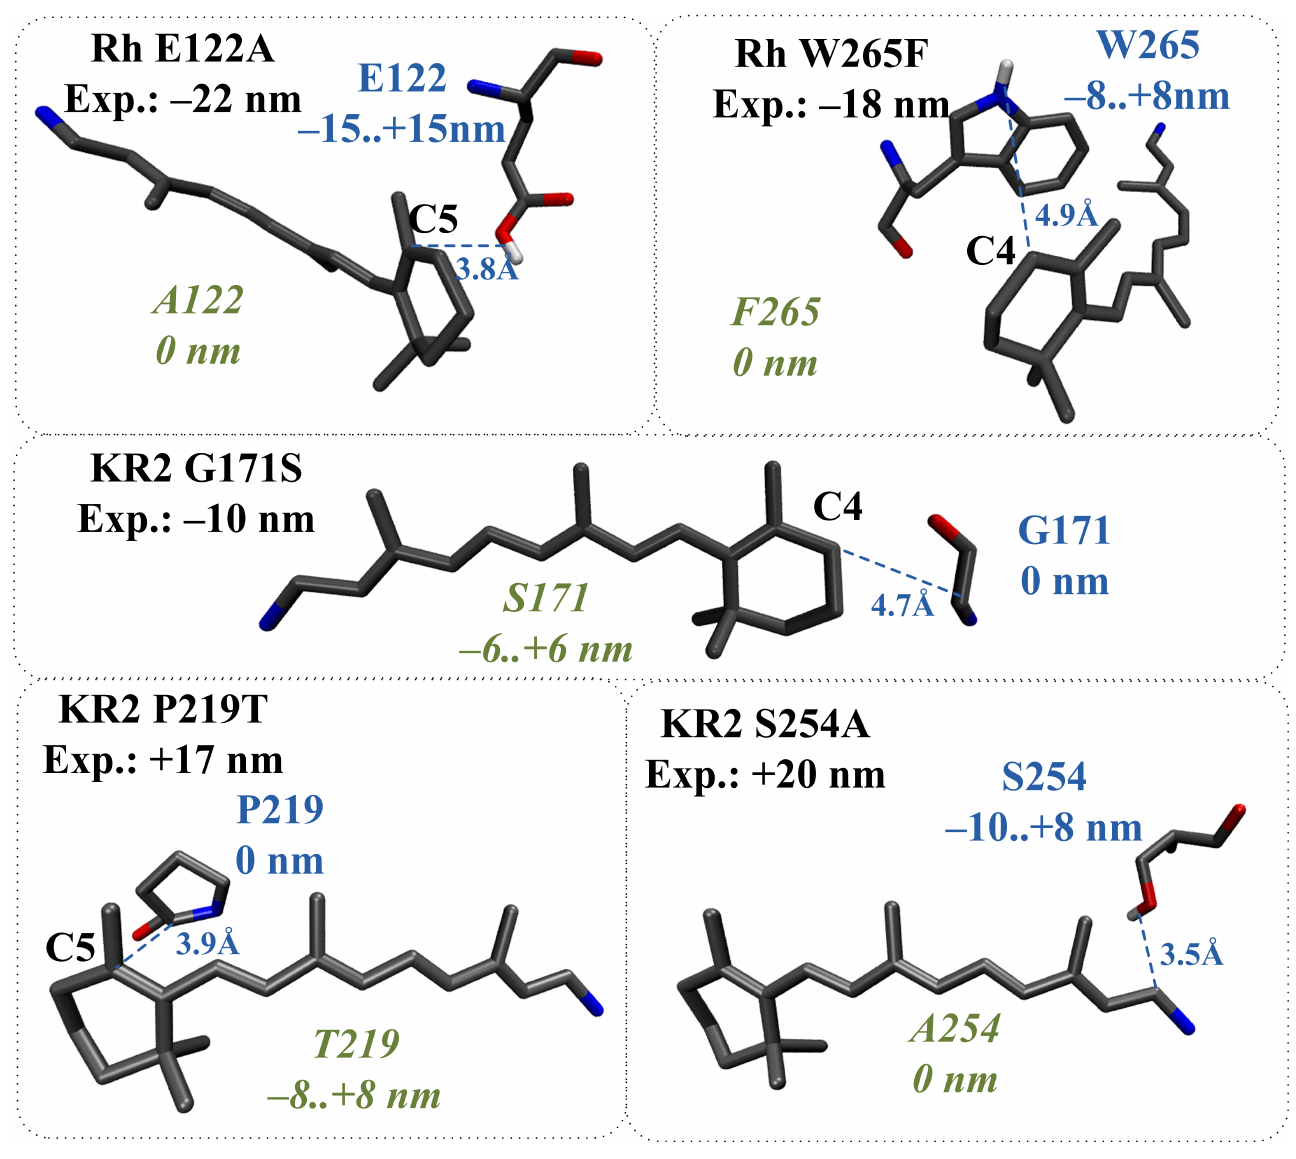
Figure 9. Bovine rhodopsin (Rh) and sodium pumping rhodopsin (KR2) mutants, for which the direct effect of amino acid substitution cannot completely explain the experimentally observed spectral shift. Experimental spectral shifts are shown in black. The distances from the wild-type residues to the PSB and corresponding contributions to λ max are shown in blue. The evaluated contributions of new residues to λ max are shown in green. The distances are given in